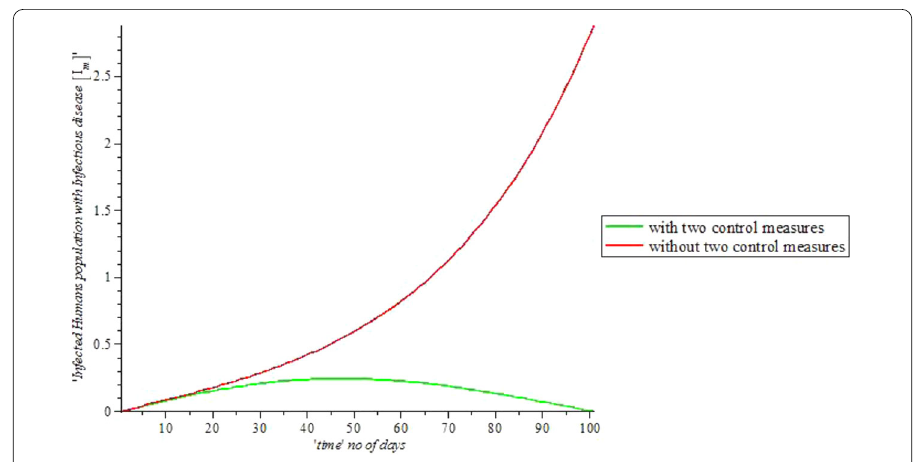
Figure 5 The optimal control system using the combination of the two